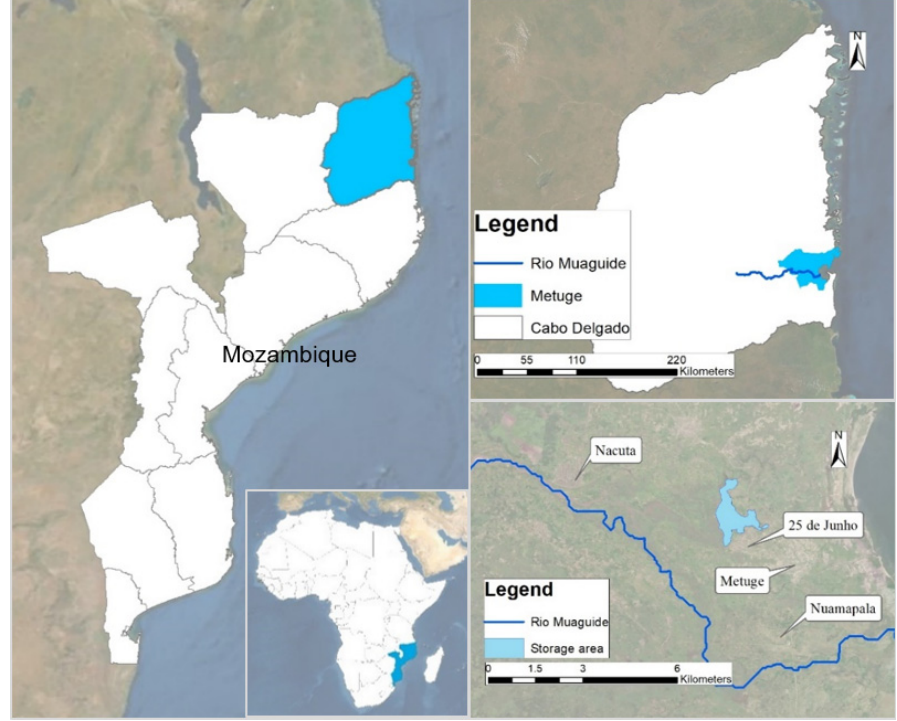
Figure 1. Localization of the study area.